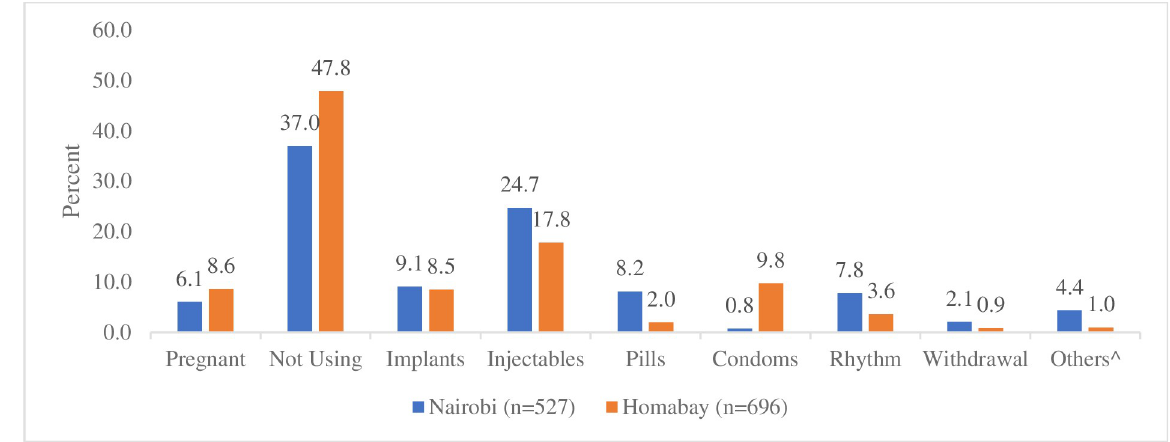
Fig 2. Method choice at 12-month follow-up by site � . � Among women not using any method at baseline but were aware of pills, injectables and implant. ^Others include female sterilization, IUD, Condom, Lactational Amenorrhea method, Rhythm and withdrawal